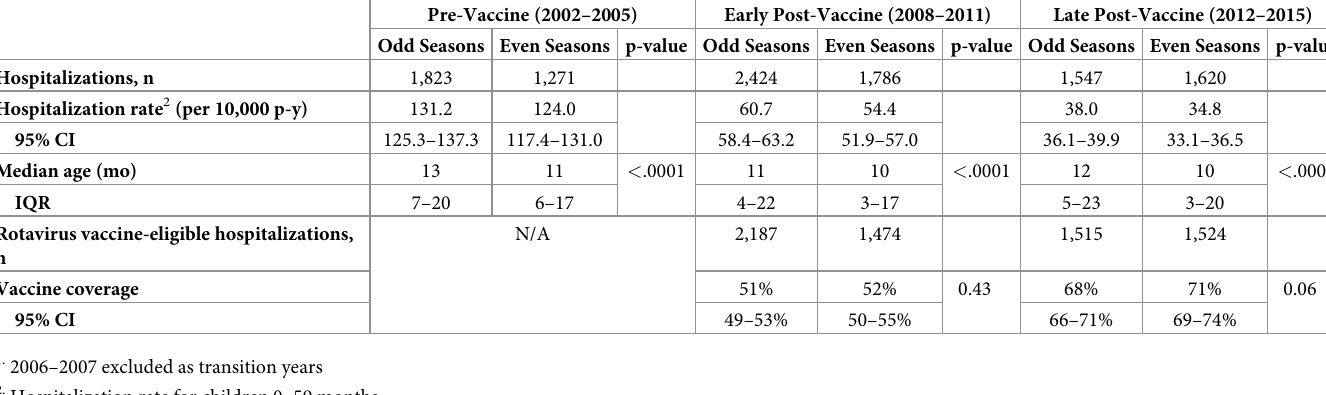
Table 2. Age and vaccination coverage for children < 60 months admitted for acute gastroenteritis during rotavirus seasons (Jan-Jun) before and after vaccine introduction 1